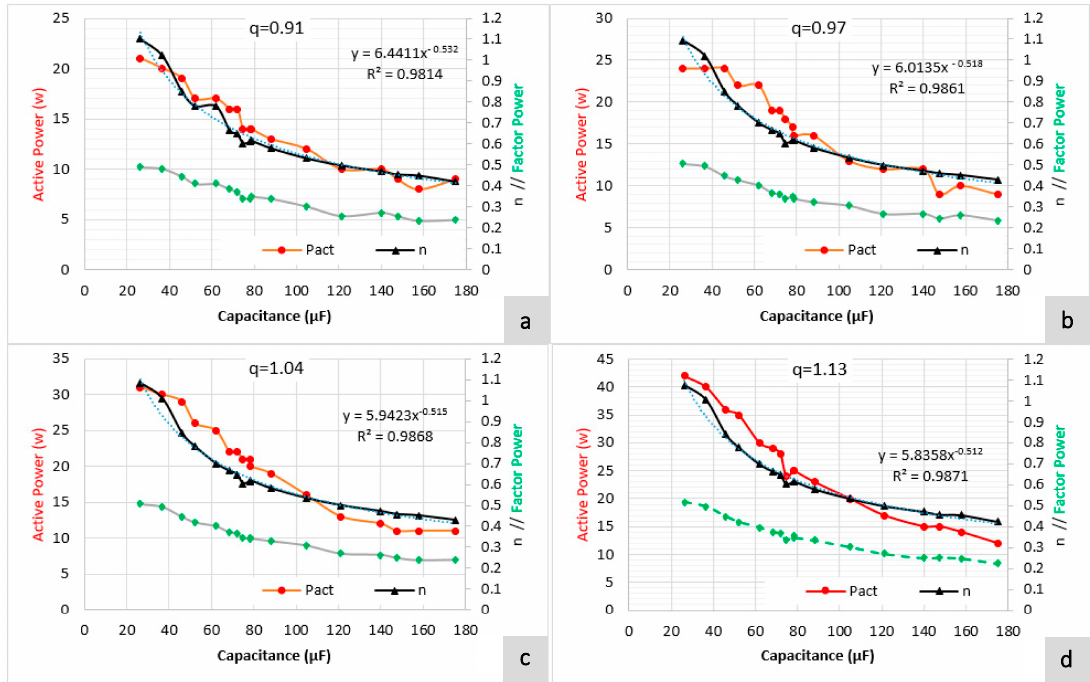
Figure 8. Active power, factor power and relative rotational speed as a function of capacitance for different relative flows, q . ( a ) q = 0.91; ( b ) 0.97; ( c ) 1.04; ( d )